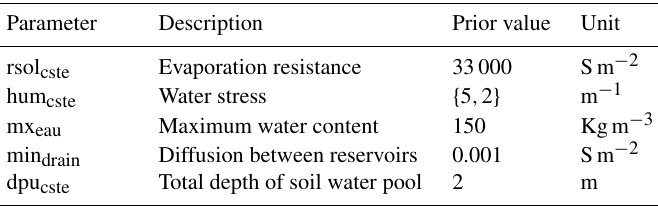
Table 1. SECHIBA inner parameters used in this work. There are five inner parameters involved in the model estimations that are controlled, plus six multiplicative factors, all equal to 1.